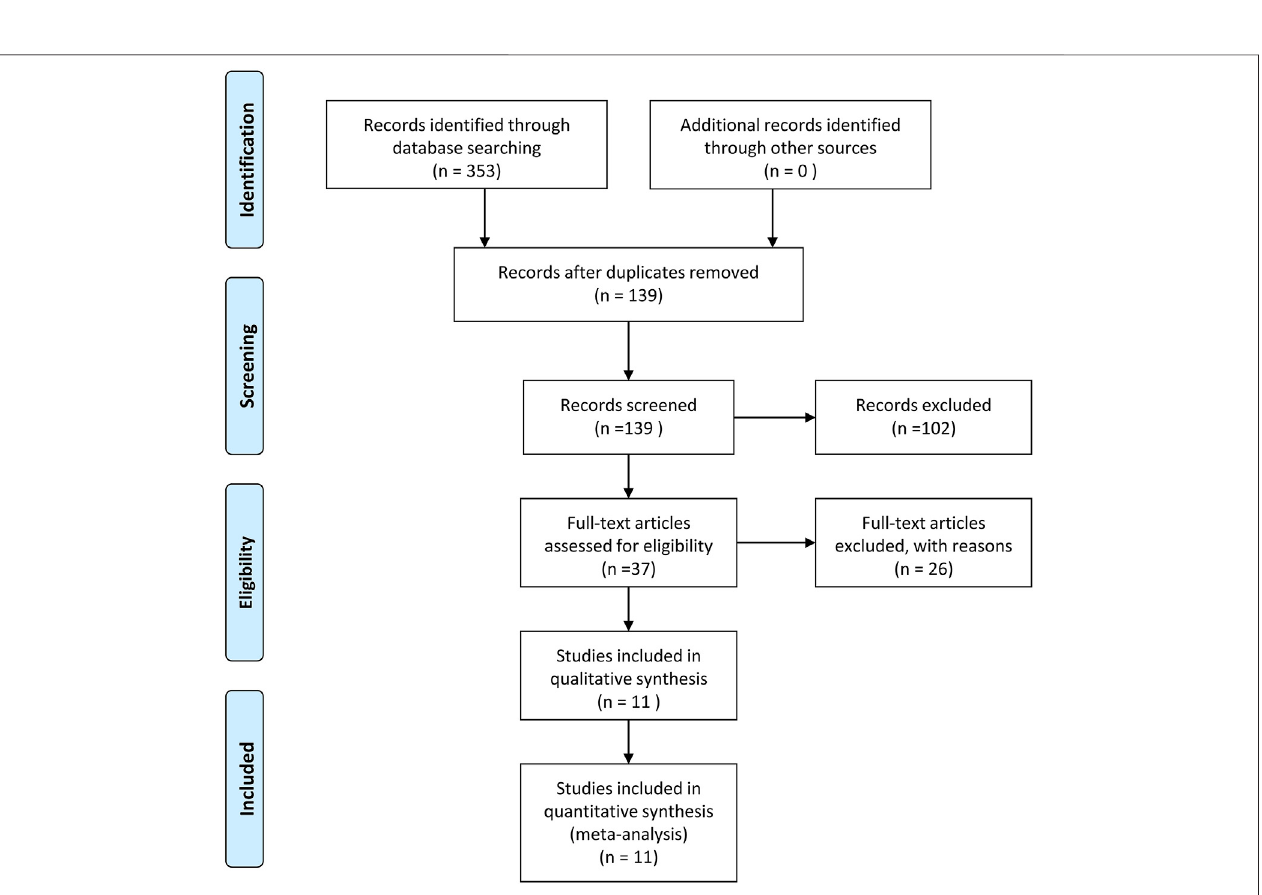
FIGURE 1 | Flowchart of the study selection